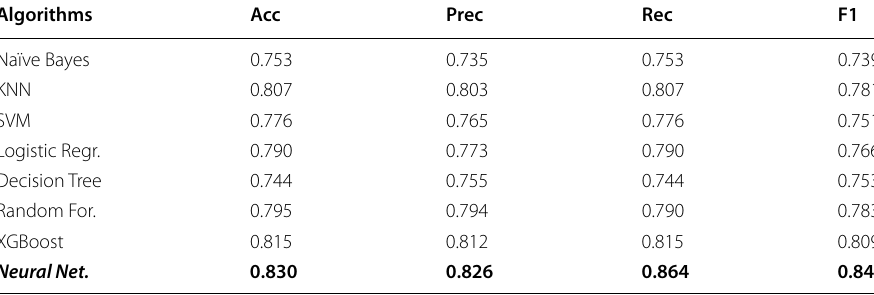
Decision Tree Random